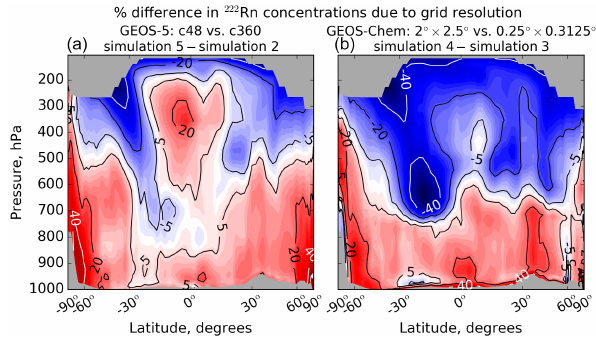
Figure 4. Effect of grid resolution on simulated zonal mean 222 Rn concentrations for July 2013. (a) Percentage differences between online GEOS-5 simulations at c48 resolution (simulation 5) and c360 resolution (simulation 2). (b) Percentage differences between off-line GEOS-Chem simulations at 2 ◦ × 2.5 ◦ resolution (simula- tion 4) and 0.25 ◦ × 0.3125 ◦ resolution (simulation 3).